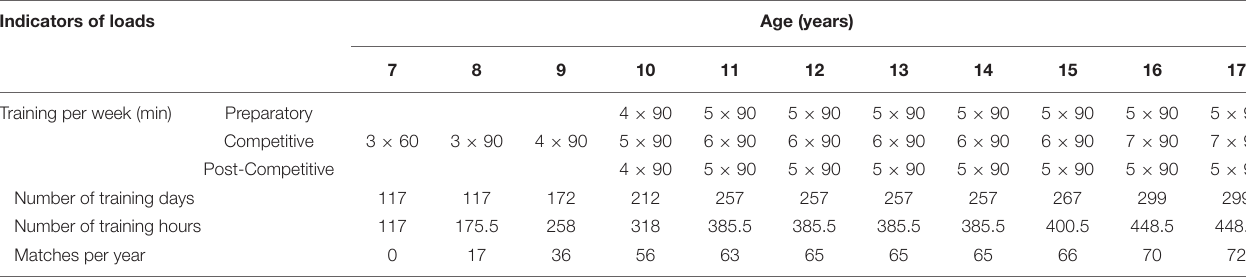
TABLE 1 | Structure of loads for the young Lithuanian basketball players aged 7–17 years. Indicators of loads